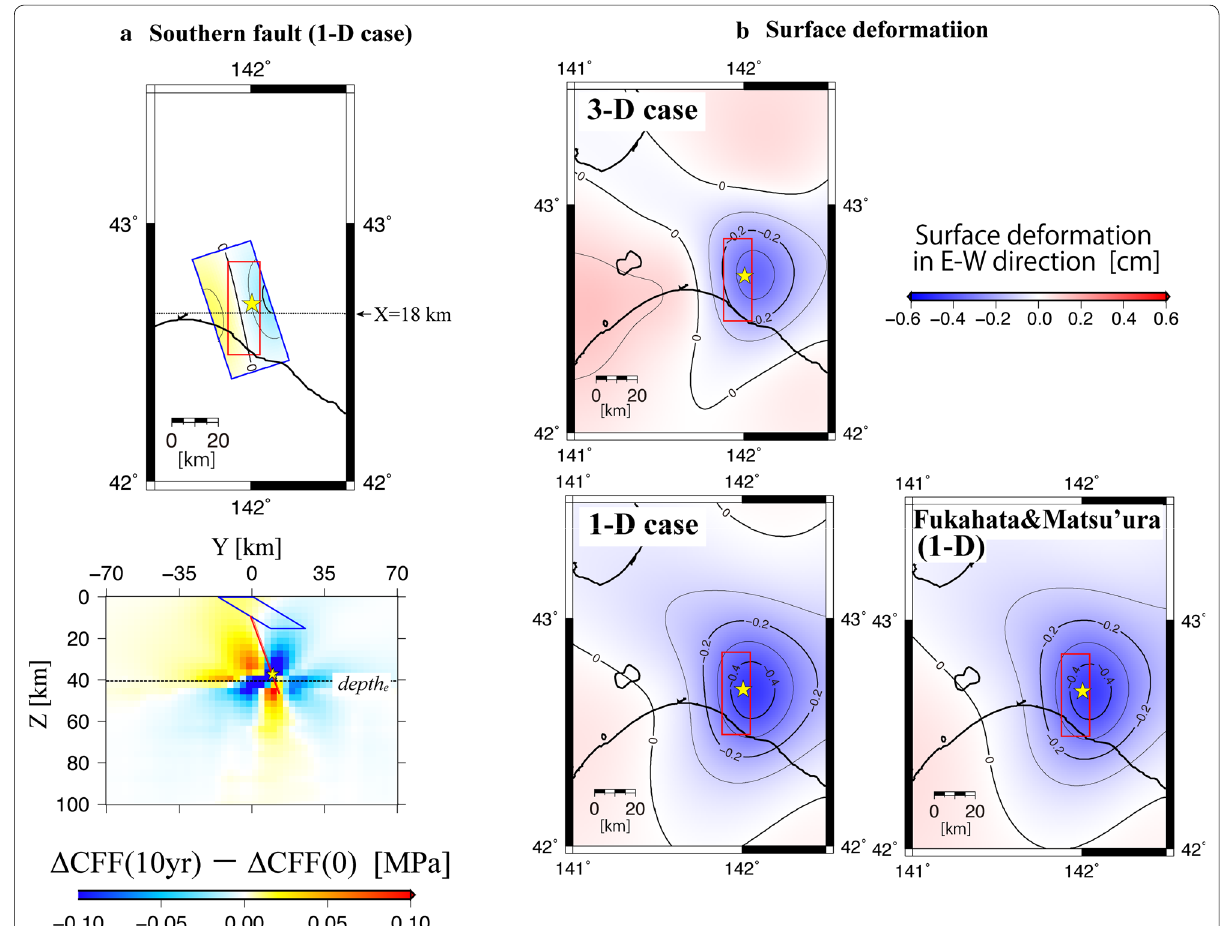
Fig. 8 a Post-ΔCFF distribution for the southern fault calculated assuming the 1-D viscoelastic structure. See the captions of Figs. 5 and 6 for an explanation of the figure. b Surface deformation in the E–W direction (eastward positive) for 10 years following the Iburi earthquake. The top and bottom left panels show the calculated deformation patterns for the 3-D and 1-D viscoelastic structures, respectively. The right bottom panel also shows the computed E–W deformation assuming the 1-D viscoelastic structure but calculated using methods of Fukahata and Matsu’ura (2005,